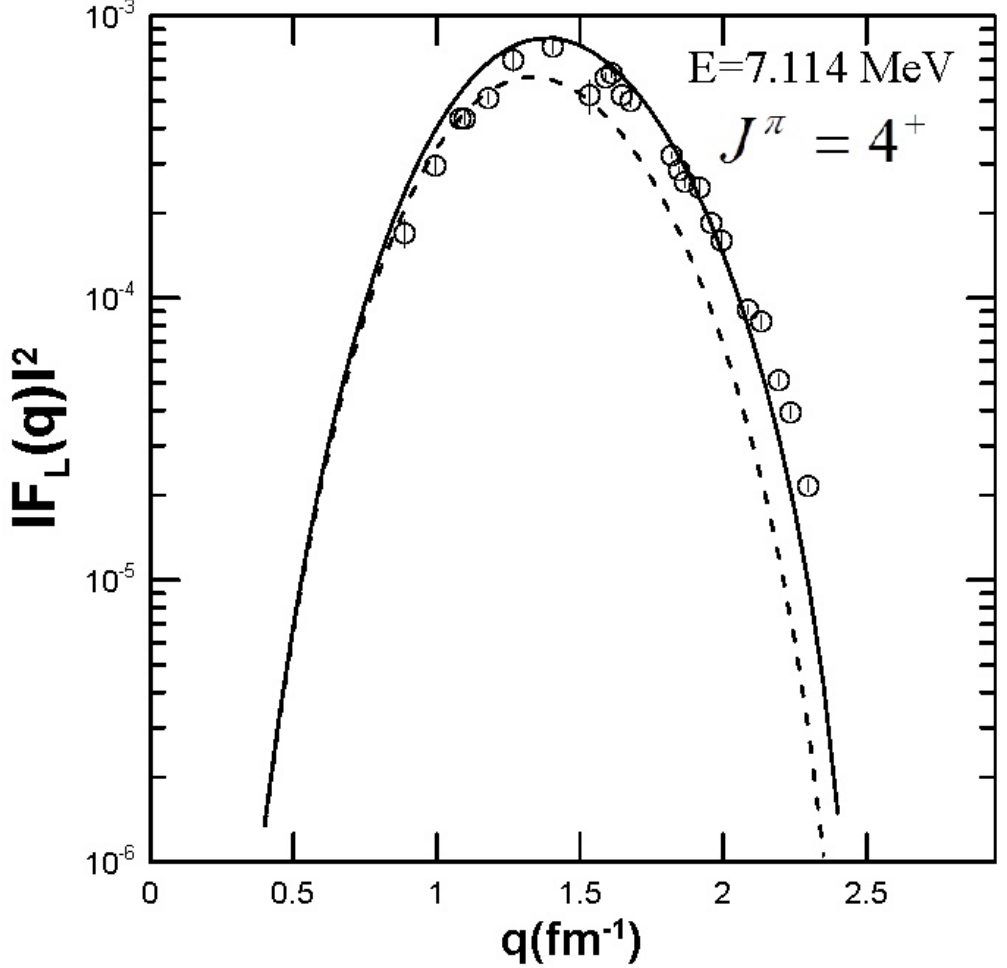
Fig. 2: Inelastic Coulomb 4 C form factors for the transition to the 14  (7.114 MeV) state. The long-dashed and solid curves are the calculated 4 C form factors without and with the inclusion of the effect of the SRC, respectively. The open circle symbols are those of the experimental data taken from ref.